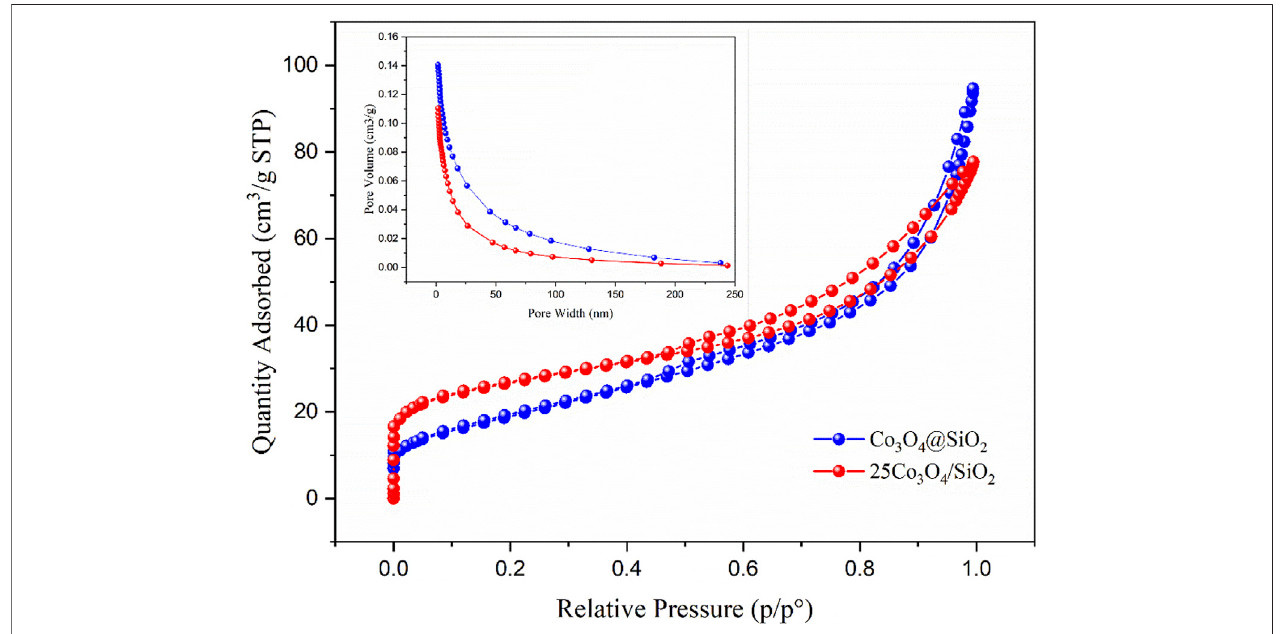
FIGURE 3 | Nitrogen adsorption-desorption isotherms and BJH pore-size distribution curves of Co 3 O 4 @SiO 2 and 25Co 3 O 4 /SiO 2 .